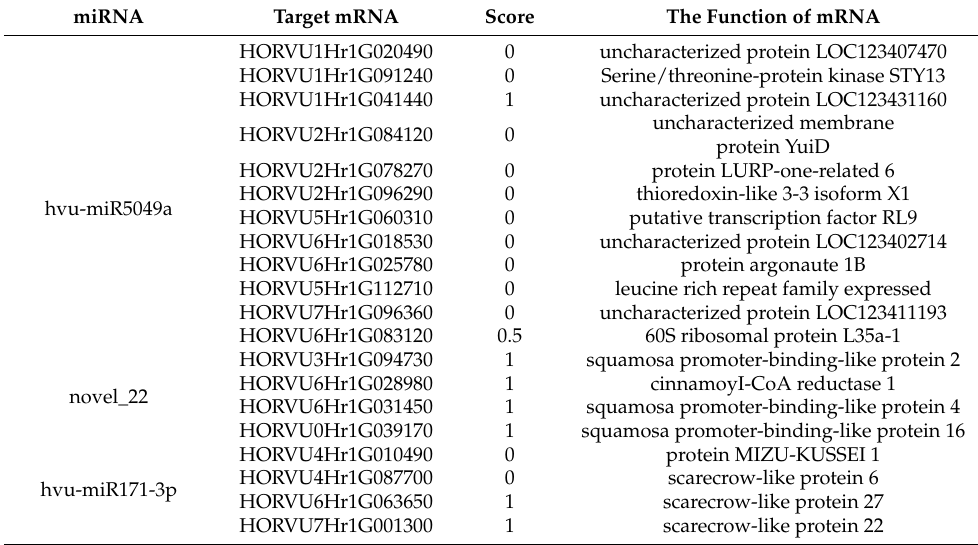
Figure 5. Venn diagrams showing the sample-exclusive or communal presence of unique putative endogenous miRNAs. ( A ) putative endogenous miRNAs in 7 dai-mock vs. 3 dai-mock, ( B ) miRNAs in 3 dai-mock vs. 7dai-3dai; ( C ) miRNAs in 7 dai-mock vs. 7 dai-3 dai; ( D ) miRNAs in 3 dai-mock vs. 7 dai-3 dai vs. 7 dai-mock.